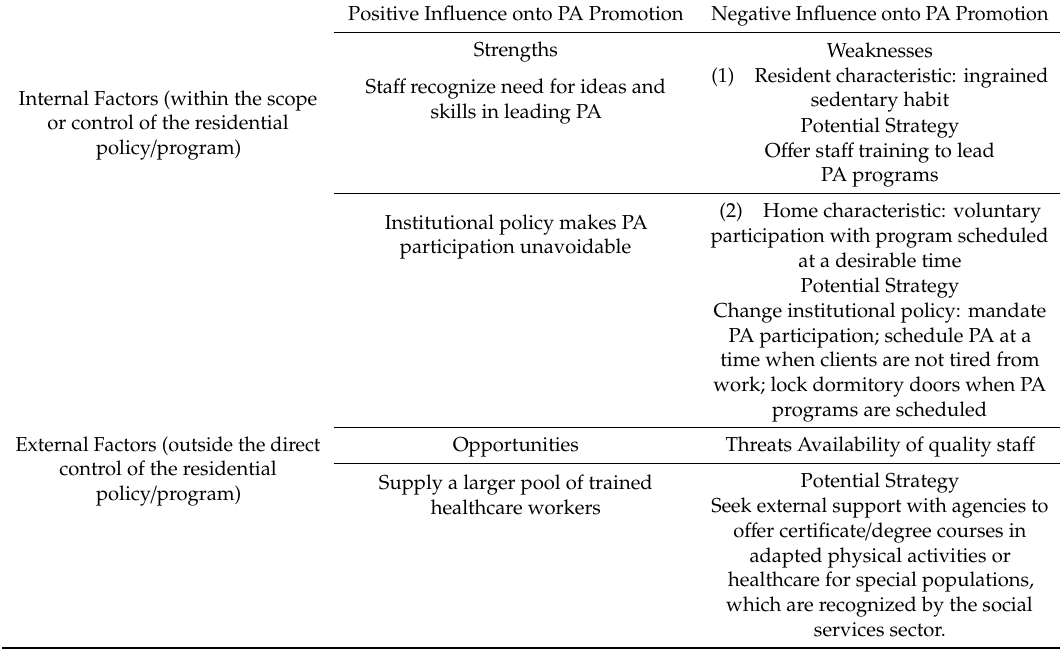
Table 3. Examples of potential strategies for physical activity (PA) promotion to generate strengths and opportunities based on a SWOT